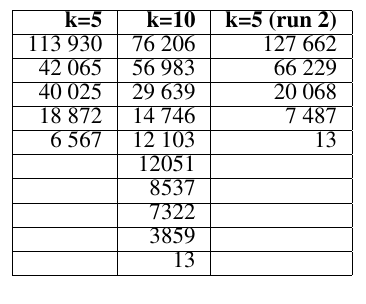
Table 2. Number of time series per cluster for displayed cluster results for ALS-TEXEL, for k=5 (2x) and k=10.